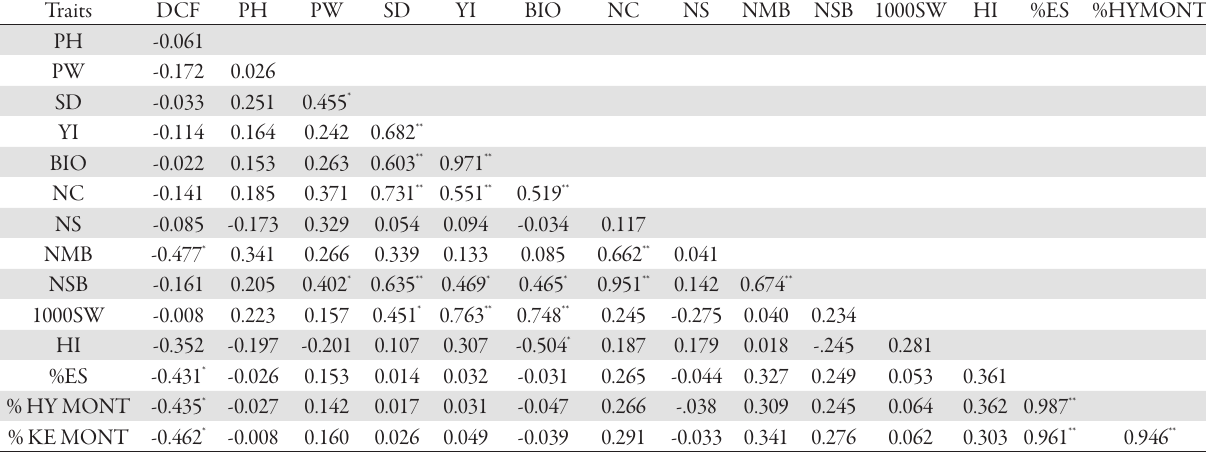
Tab. 1. Simple correlation coefficients of black seed characters under normal irrigation conditions